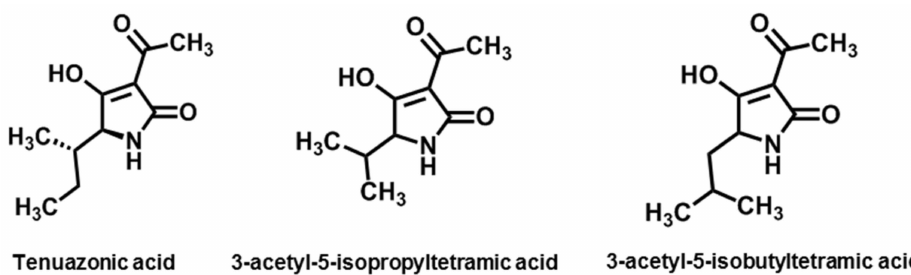
Figure 9. Chemical structures of Alternaria NHSTs belonging to the tertramic acids